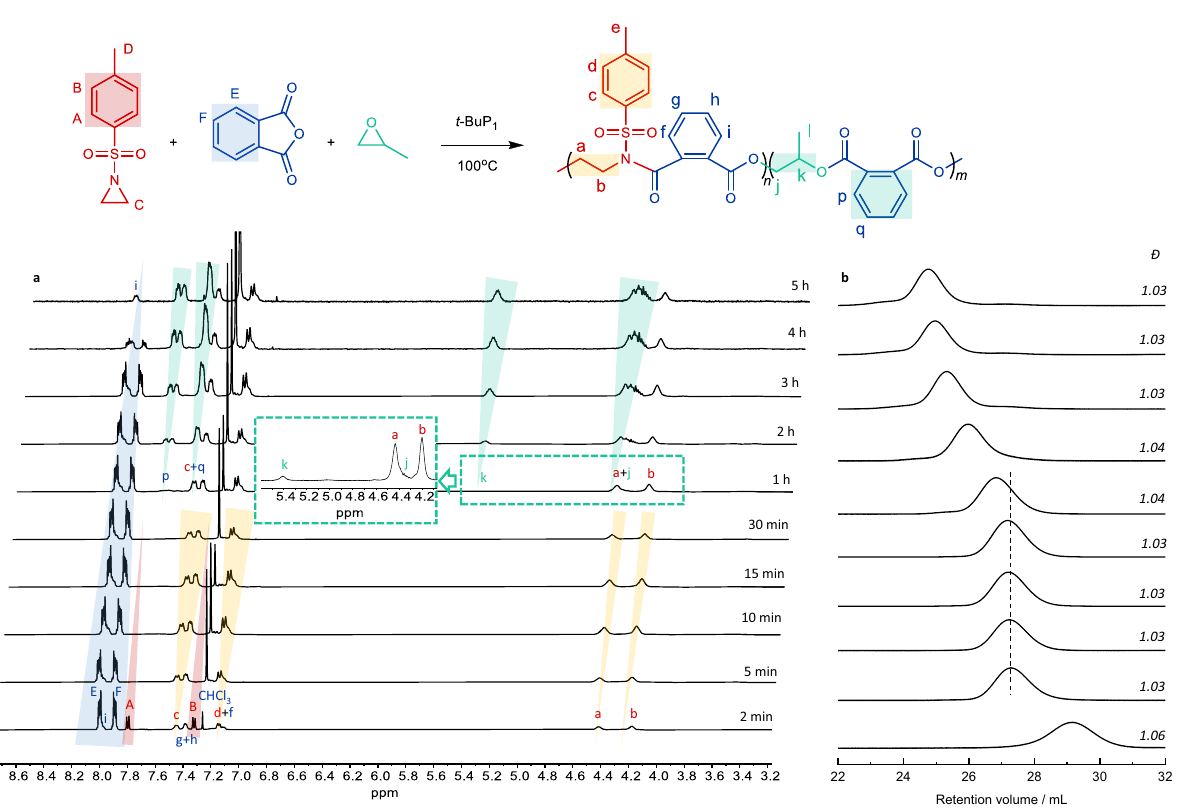
Fig. 2 Terpolymerization of TAz, PA, and PO at different reaction times. a Characteristic signals monitored by 1 H NMR spectra. b Retention volume monitored by SEC traces (entries 7 and 8 in Table 1 and Supplementary Table